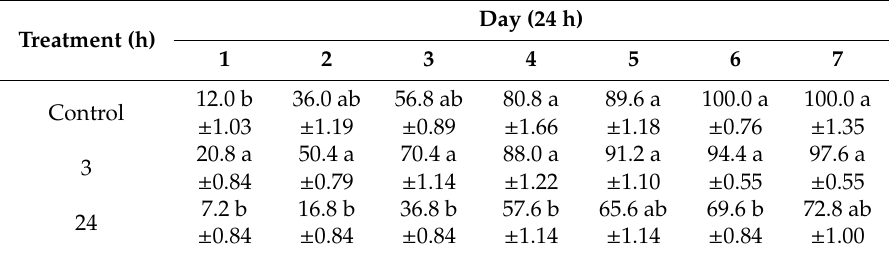
Table 1. Germination percentage of triticale ( × Triticosecale Wittm. ex A.Camus) grains irradiated with a helium-neon (He-Ne) laser by 3 and 24 h; mean ± SD (n = 10) values marked with di ff erent letters di ff er statistically according to Tukey’s test at p ≤ 0.05.